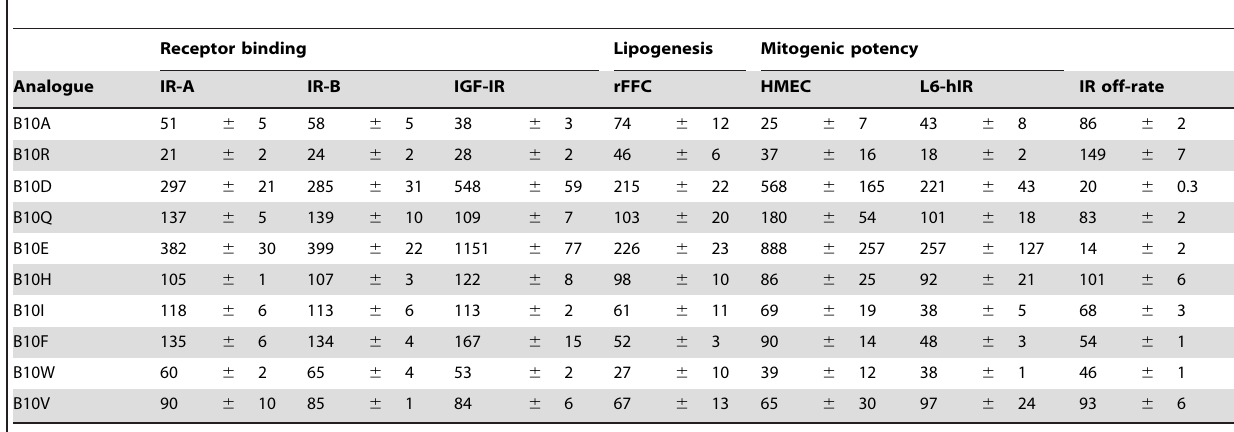
Table 1. Relative receptor affinities, metabolic and mitogenic potencies, and IR off-rates [% of human insulin].